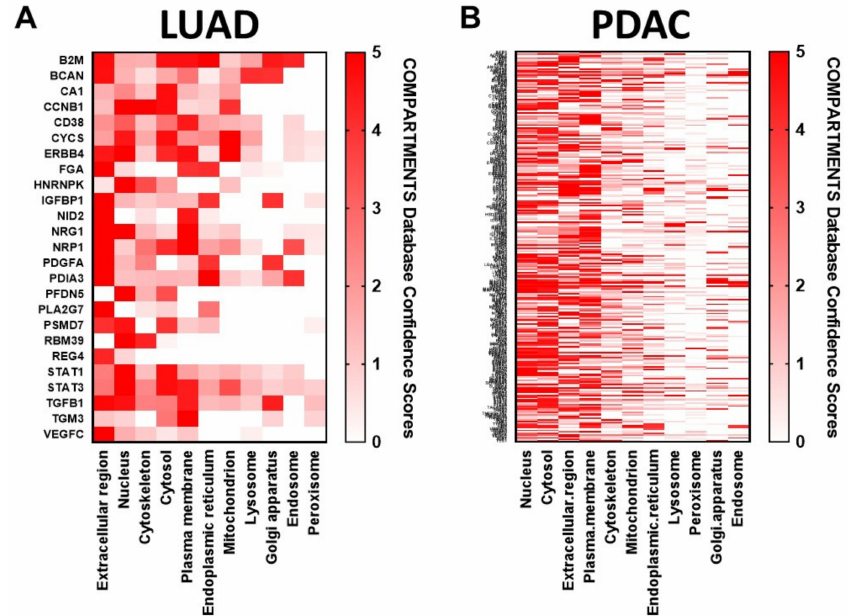
Figure 4. COMPARTMENTS subcellular localization analysis for ( A ) LUAD and ( B ) PDAC plasma-derived sEV features exhibiting ROC AUC classifier performance of > 0.7 that were also identified in adenocarcinoma cell line-derived sEVs. The red shading indicates the COMPARTMENTS integrated confidence score for localization to each of eleven indicated subcellular compartments. A full list of the genes together with their compartment confidence scores is provided in Data S7 and